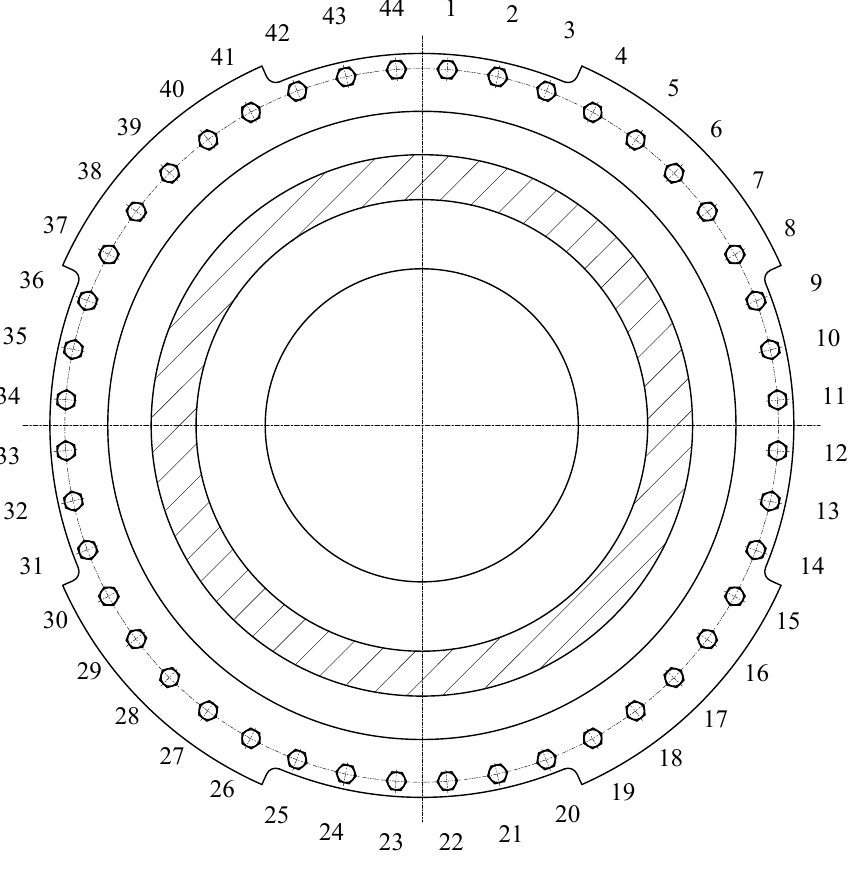
Figure 4. Bolt serial